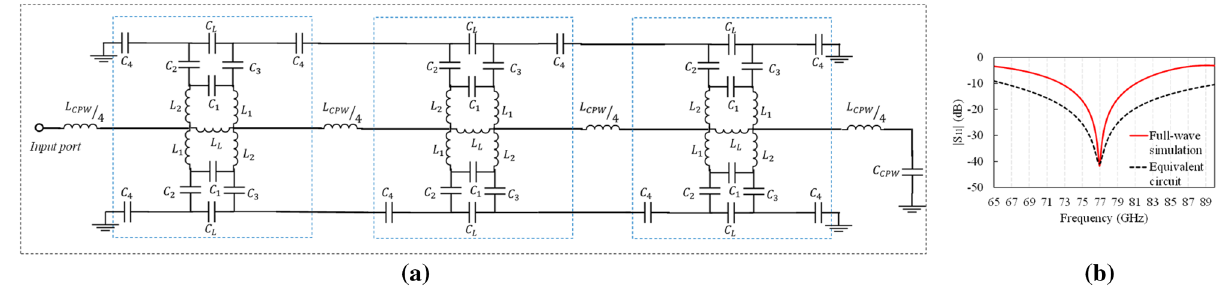
Figure 9. ( a ) Proposed equivalent circuit, and ( b ) comparison of equivalent circuit with full-wave simulation results.